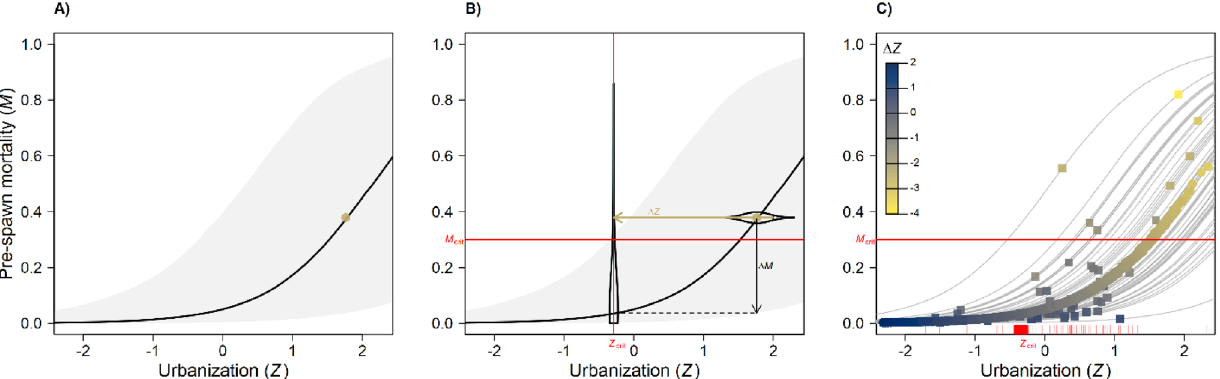
Figure 3. Predicted pre-spawn mortality ( M ) increases with urbanization, represented by the latent factor Z in the hierarchical Bayesian structural equation model of 42 . ( A ) shows the posterior median logistic regression function (black curve) and associated 90% credible interval for a site whose current conditions ( Z cur and P [ M | data]) are shown as a point estimate. ( B ) Given this relationship and a specified critical mortality risk ( M crit = 0.3, horizontal red line), we estimated the level of urbanization ( Z crit , vertical red line) that gives a probability 1 – α of exceeding